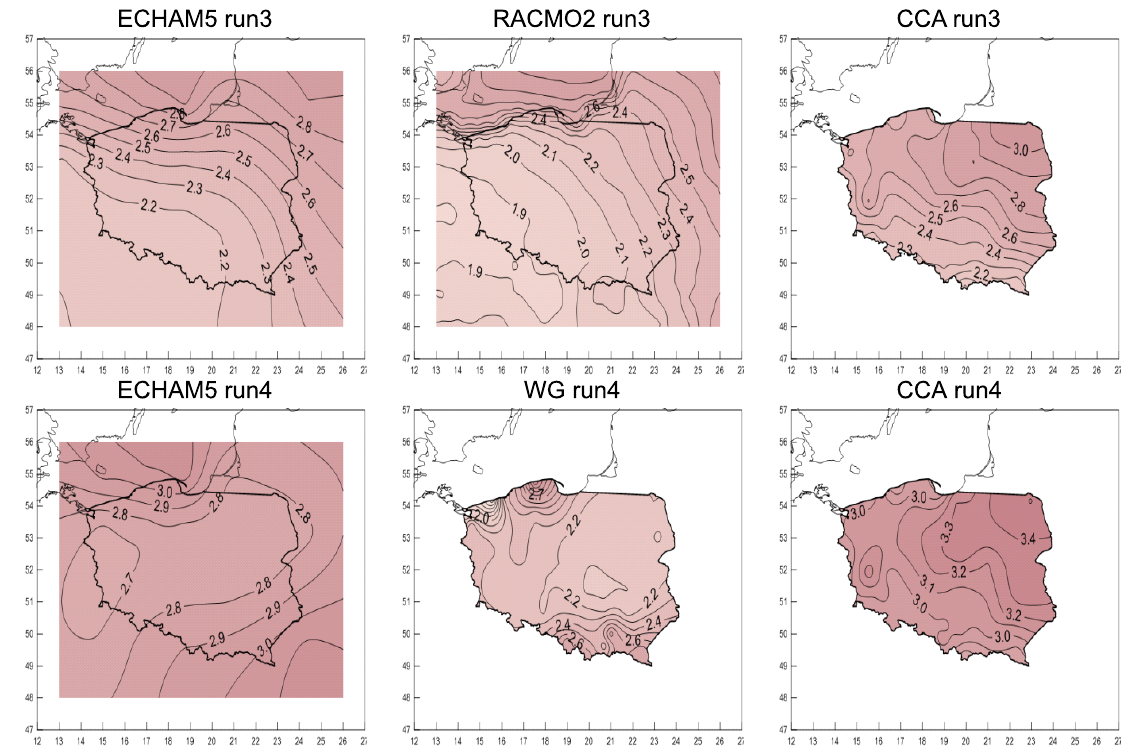
Fig. 10. Anomalies of air temperature (°C) in the spring season (MAM) 2071–2090 in relation to reference period (1971–2000) in Poland based on A1B emission scenario for models: ECHAM5 run 3and 4, RACMO2 run 3, CCA run 3 and 4, WG run